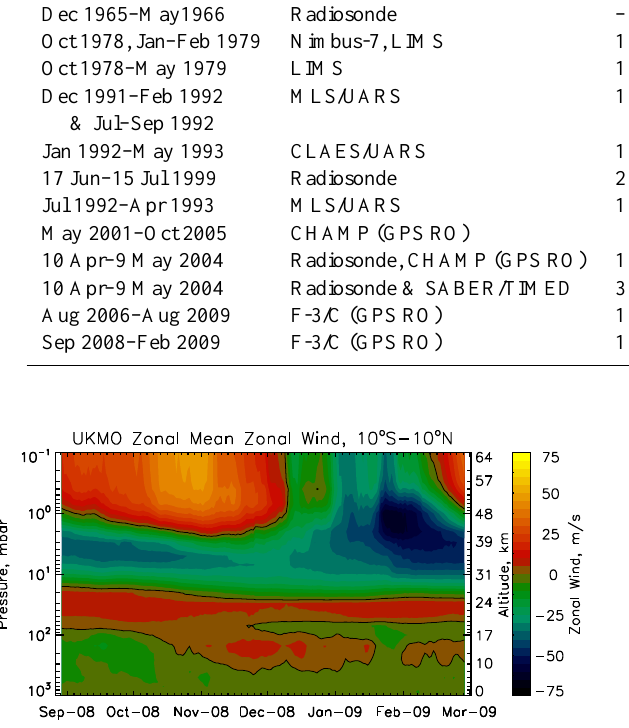
Fig. 8. UKMO daily zonal mean zonal wind during September 2008 to February 2009 averaged over 10 ◦ S–10 ◦ N. Observe the decrease in the easterly wind during November and December at